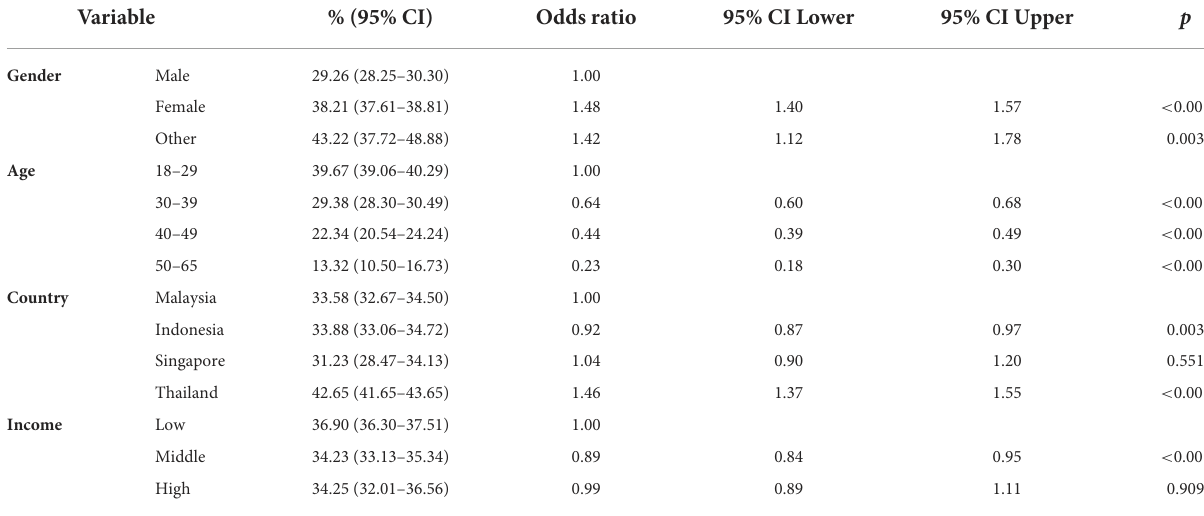
TABLE 5 Factors associated with severe/extremely severe stress symptoms. Variable